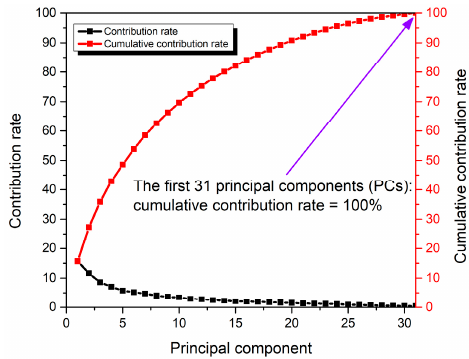
Figure 7. Contribution rate of each PC and their cumulative contribution rate of the PCs.